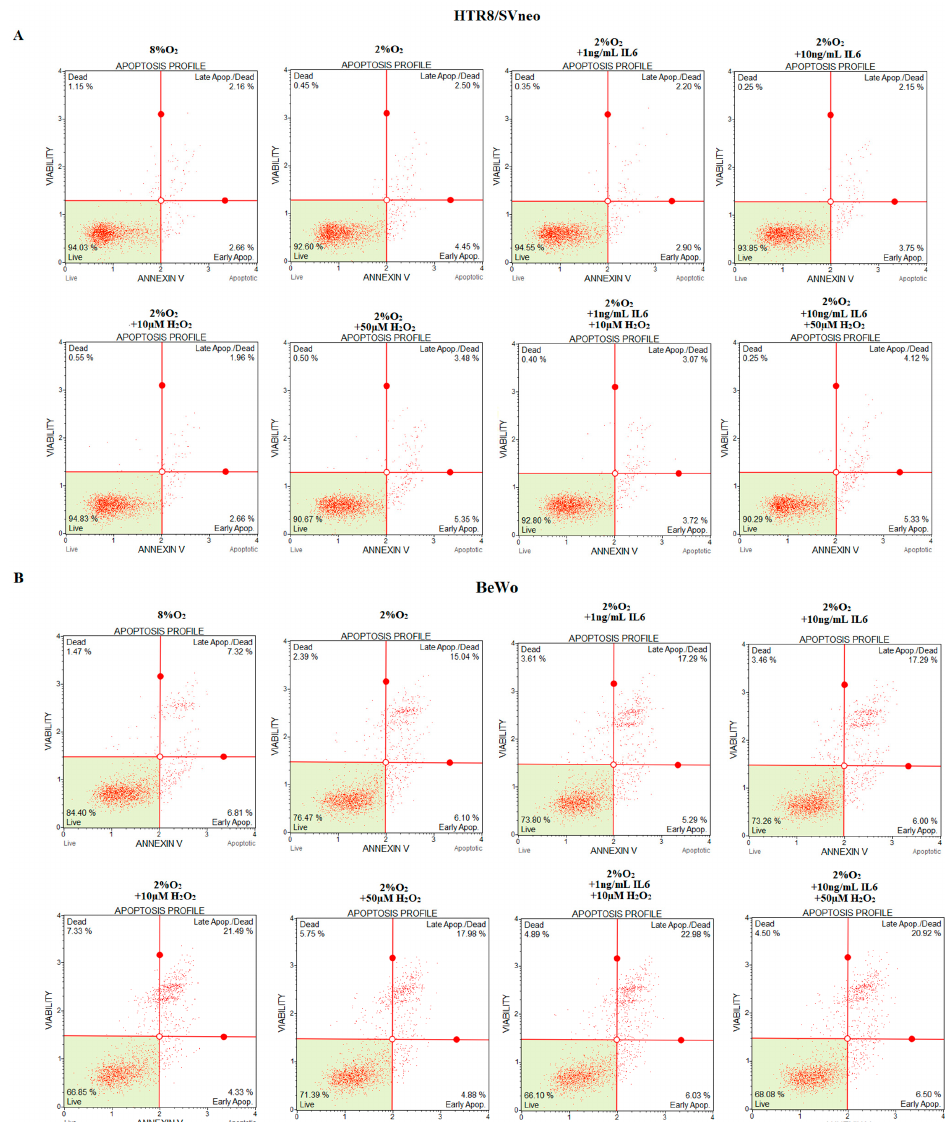
Figure 4. The representative results of the apoptosis profile obtained by flow cytometry with the Apoptosis Assay for Muse Cell Analyzer of differently stimulated HTR-8/SVneo ( A ) and BeWo ( B ) cells.